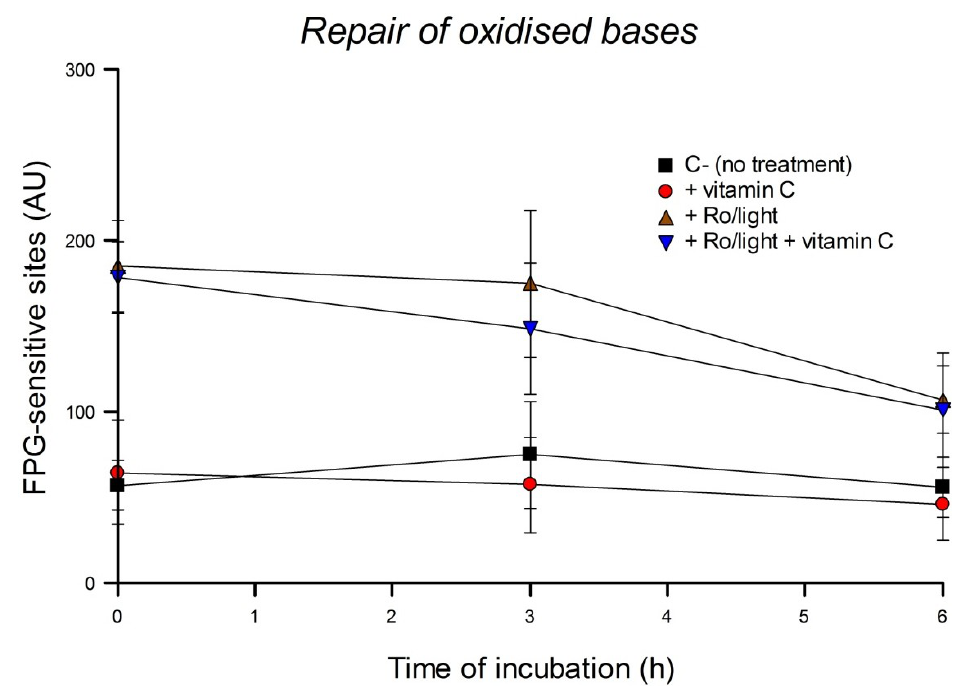
Figure 5. Effect of incubation of HeLa cells with 200 µM of vitamin C before and during the repair of oxidized bases induced by Ro plus light; residual FPG-sensitive sites were measured at different time points. Bars: SD calculated from the results of 3 independent experiments. No significant effects were